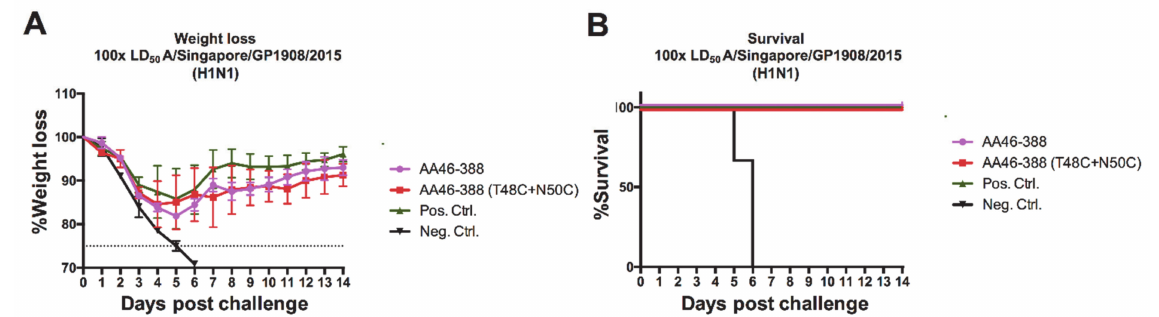
Figure 6. Challenge of vaccinated mice with a highly lethal dose of H1N1 virus. Mice were vaccinated with each of the indicated NA constructs ( n = 5 per group) in a prime boost regimen. Here, 3 ug of the respective recombinant protein adju- vanted with AddaVax was administered. As negative and positive controls, the Lassa virus glycoprotein and the tetrameric Mich15-VASP protein were administered. Mice were then challenged with 100 × LD 50 of A/Singapore/GP1908/2015. Weight loss was monitored over 14 days post-challenge ( A ). Mice were euthanized when they lost 25% of their initial weight. Survival curves are shown ( B